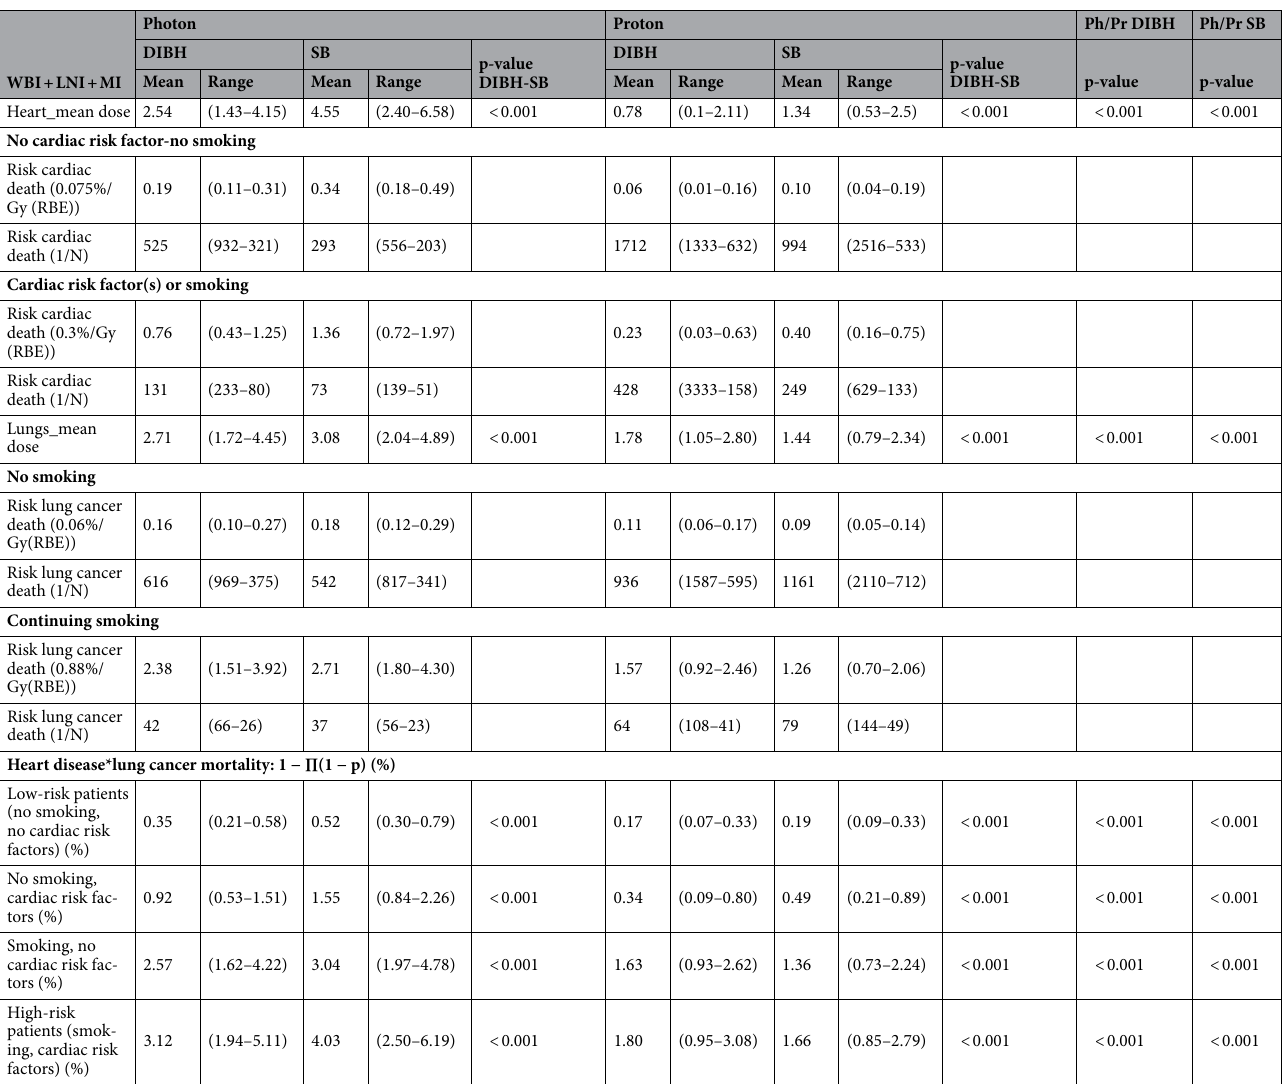
Table 2. Risk estimations for radiation-induced mortality. Risk estimations for radiation-induced mortality, based on Taylor et al. 7 . Over a 30-year period for a 50-year old (reference) patient, the absolute risk